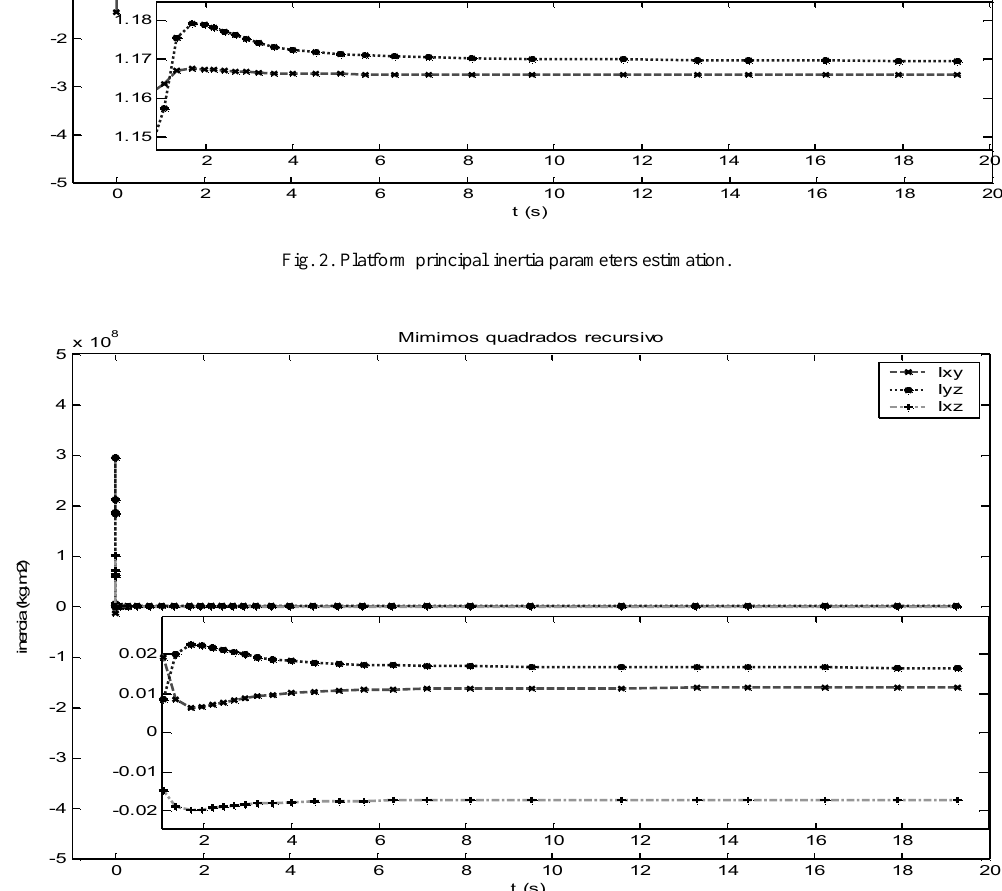
Fig. 3. Platform cross inertia parameters